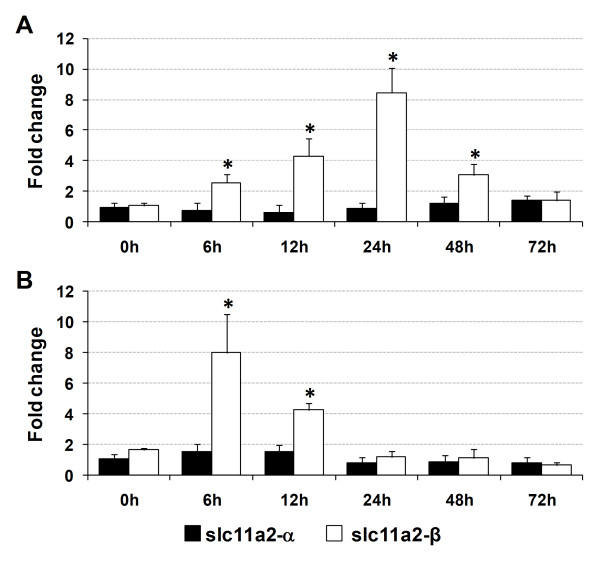
Expression of slc11a2-α and slc11a2-β in sea bass leukocytes under experimental (a) iron overload or (b) infection, in vitro. Samples were collected at 0, 6, 12, 24, 48 and 72 hours after addition of ferric ammonium citrate (iron overload) or heat-inactivated P. damselae (infection). Values are expressed as mean fold change ± S.D. (n = 5). β-actin was used as the housekeeping gene. Differences from the control group were considered significant at *p < 0.05.